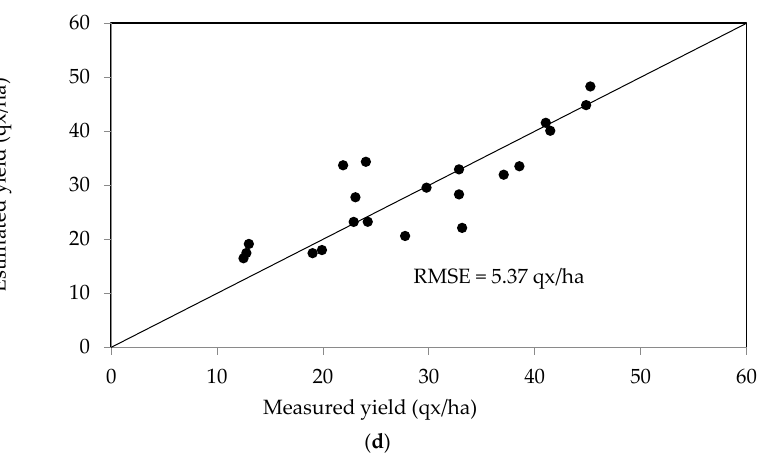
Figure 9. Relationship between the grain yields of wheat ( a ) and barley ( b ), and LAI during the period of maximum growth (A LAI ). Measured yields shown as a function of the estimated values computed using A LAI , the maximum growth LAI, for test plots and two crop years, for wheat ( c ) and barley ( d ).